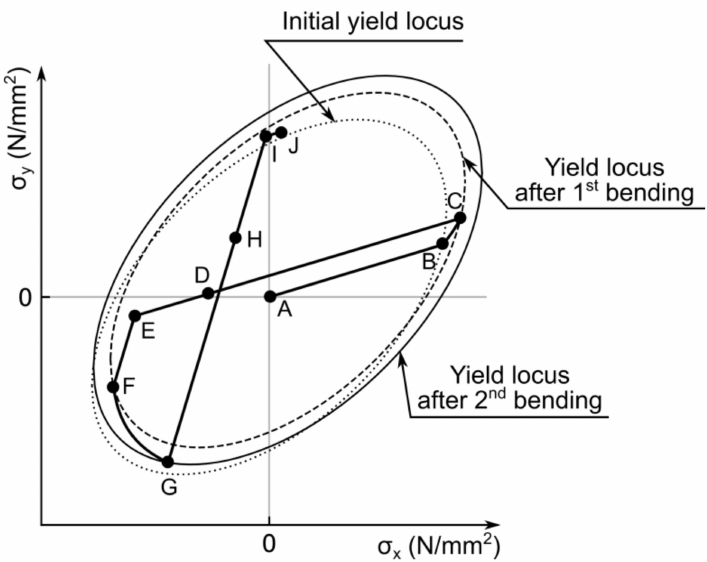
Figure 4. Yield locus displacement and stress path during bending operations.